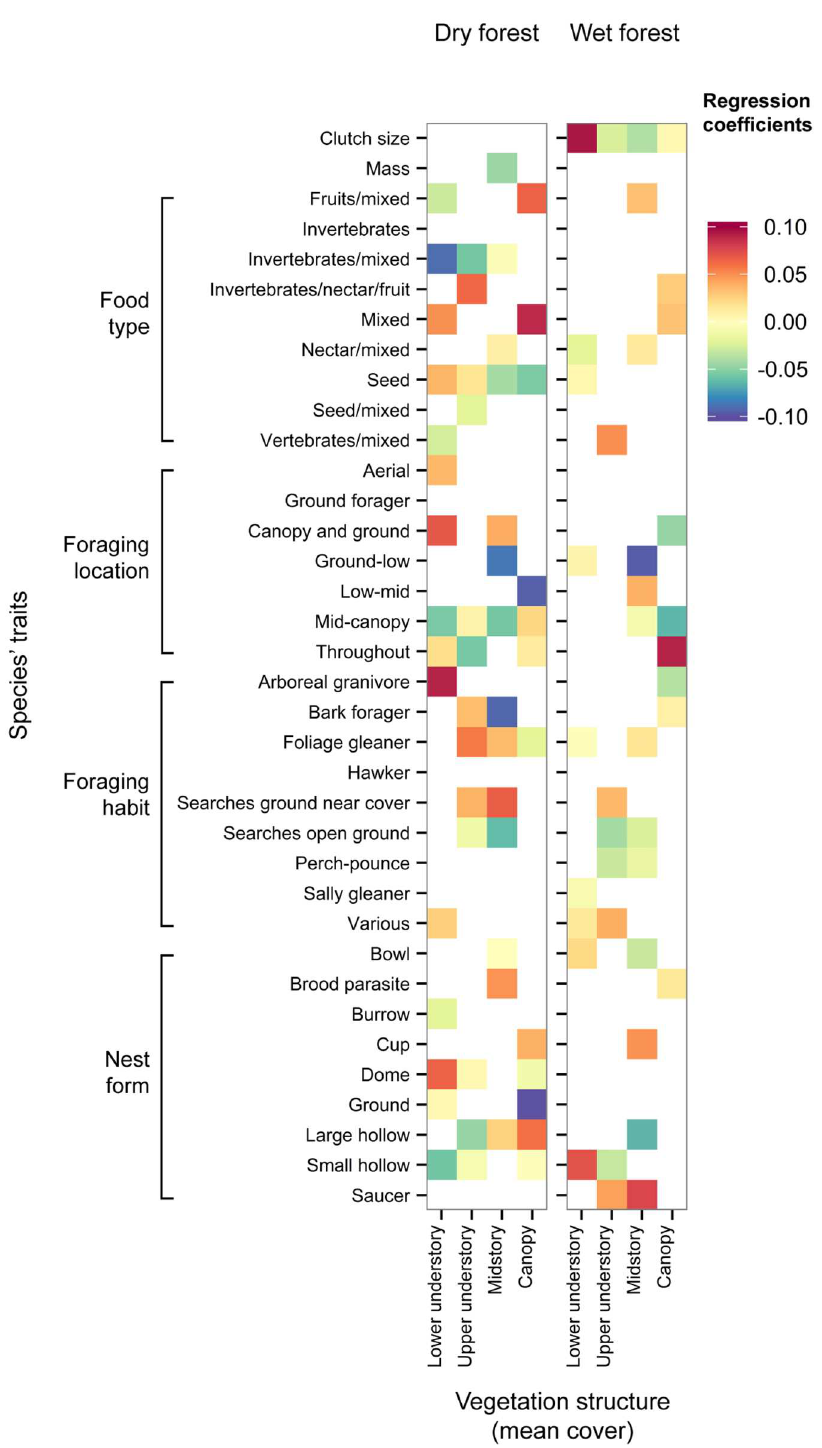
Fig 3. Fourth-corner interaction coefficients for the relationship between bird traits and vegetation structure variables. Statistically significant relationships are indicatedin red (positive) and blue (negative); the shade of the colour represents the strength of the association.Clutch size is an ordinal variable, mass is continuous and other trait variables are